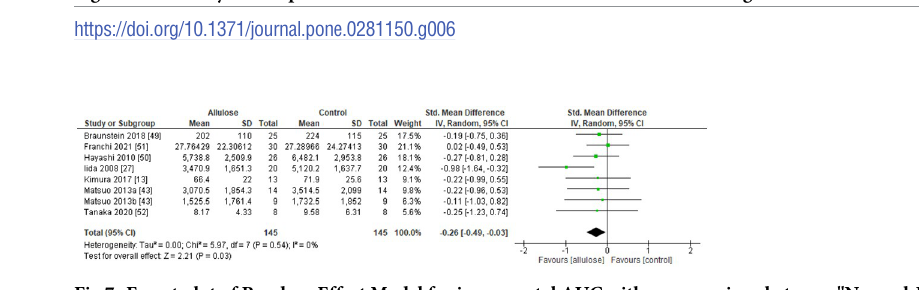
Fig 6. Preliminary funnel plot of incremental AUC at the selected studies for " < 5g" Low-Intakes and control.